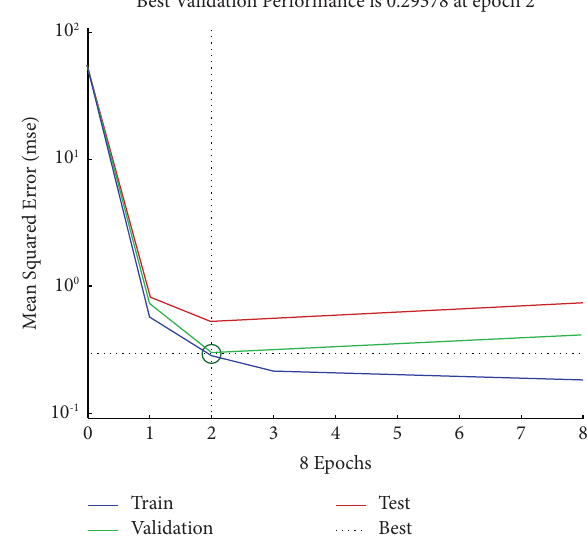
Figure 4: Te results for the best validation performance.